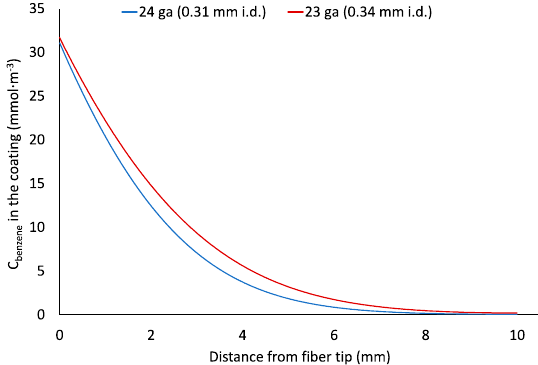
Figure 5. Effect of protecting needle gauge size concentration profile of benzene in the Car/PDMS coating after 100,000 s sampling.